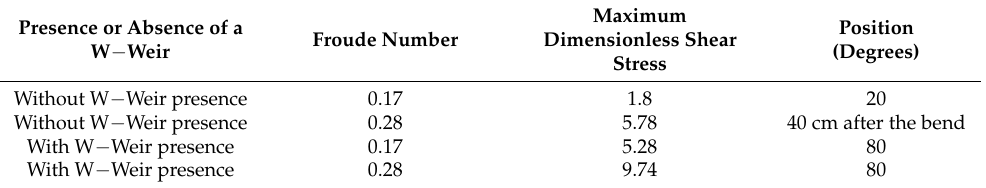
Table 4. Maximum dimensionless shear stress with and without a W −